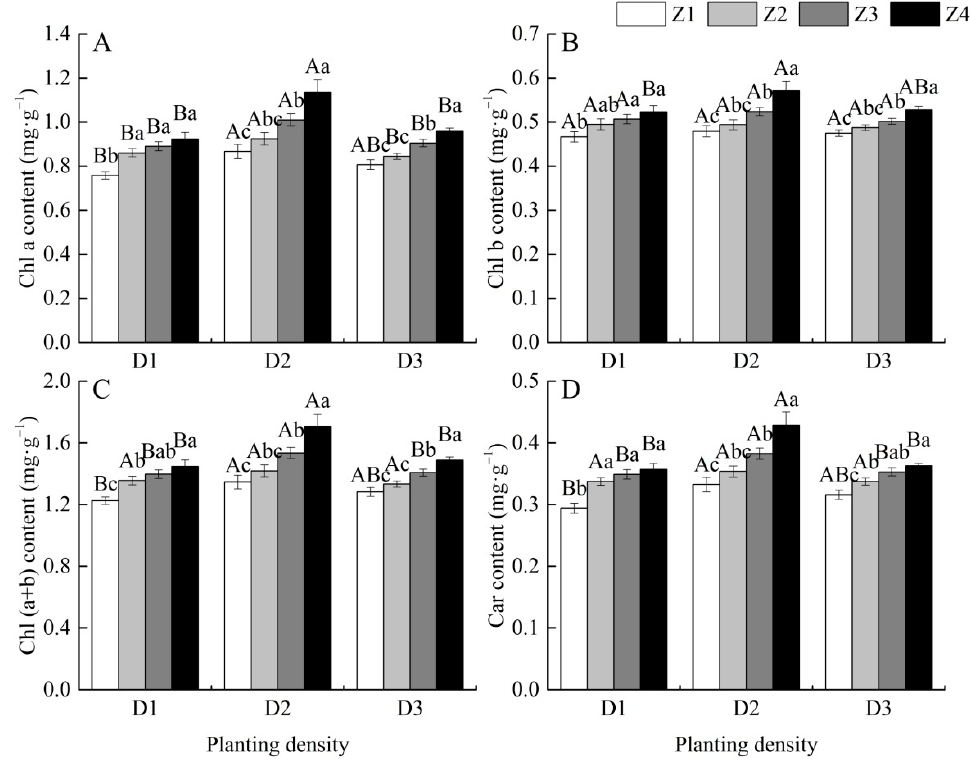
Figure 3. Chlorophyll a (Chl a, A ), chlorophyll b (Chl b, B ), Chl (a + b) ( C ), and carotenoid (Car, D ) contents of C. lanceolata saplings in different leaf positions (Z1–Z4) and under different planting densities (D1–D3; as detailed in the caption of Figure 1).